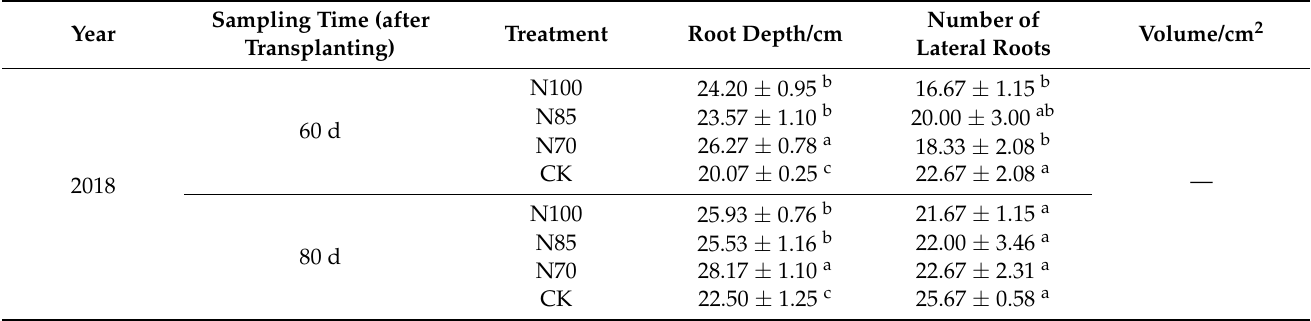
Table 6. Effect of reduced nitrogen application on nitrogen uptake in roasted tobacco.